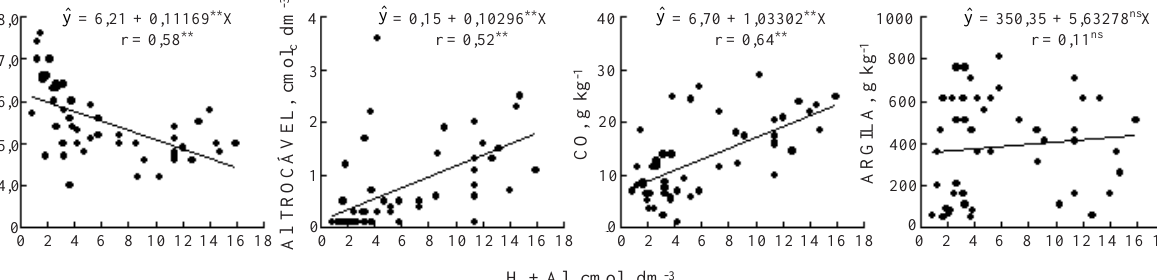
Figura 2. Correlação linear simples entre pH em água, Al trocável (Al 3+ ), carbono orgânico (CO) e teor de argila e a acidez potencial (H + Al). (** significativo a 1% pelo teste de